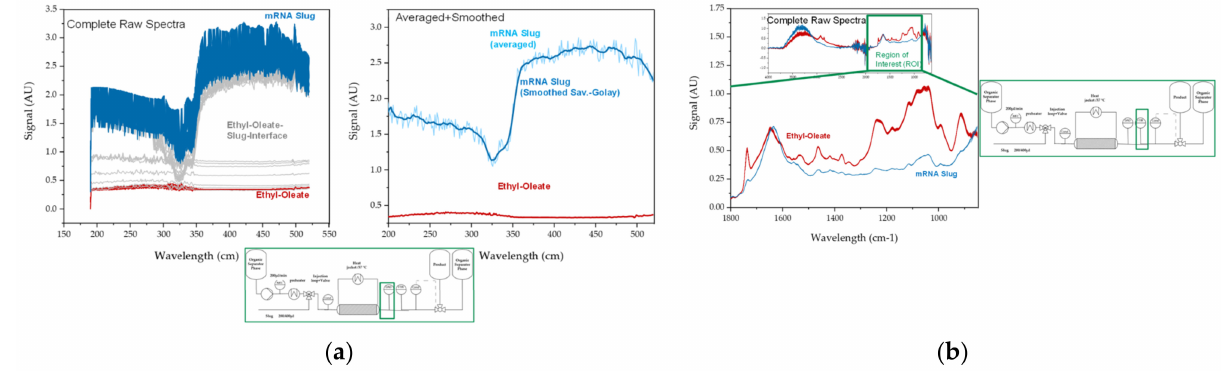
Figure 21. Spectra of ethyl oleate and slug in ( a ) DAD and ( b ) FTIR.